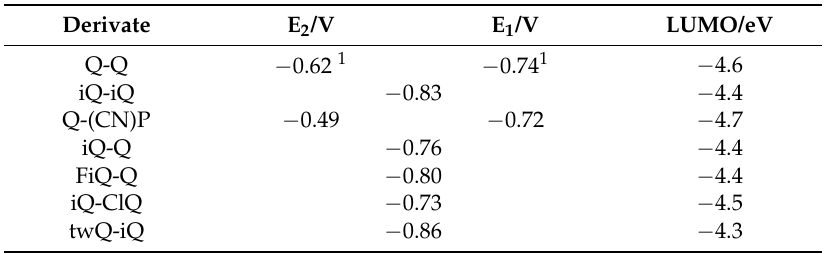
Table 1. Electrochemical data obtained from cyclic voltammograms. Derivate E 2 /V E 1